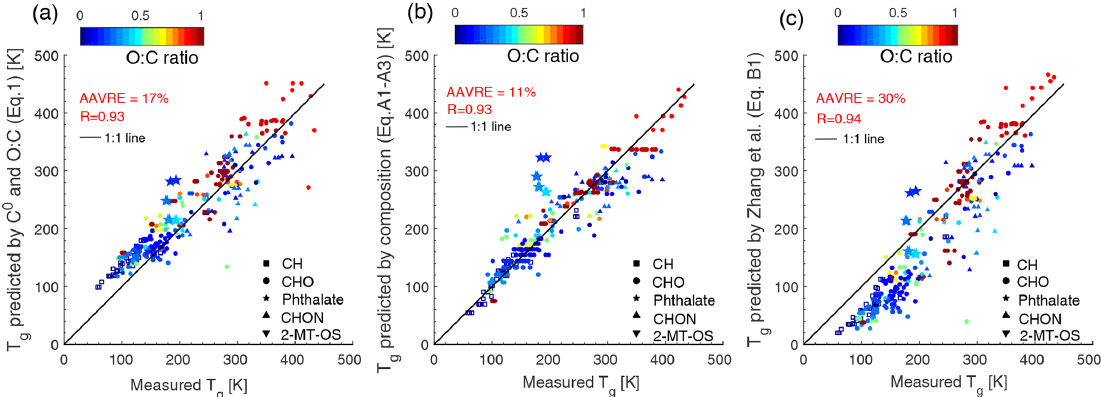
Figure B1. Comparison between measured T g in the training dataset in Fig. 1a and T g predicted by (a) C 0 and O : C (Eq. 1), (b) elemental composition (Eqs. A1–A3), and (c) the parameterization (Eq. B1) in Zhang et al. (2019). The solid line shows the 1 : 1 line. The correlation coefficient ( R ) and the average absolute value of the relative error (AAVRE) are included in each figure legend.